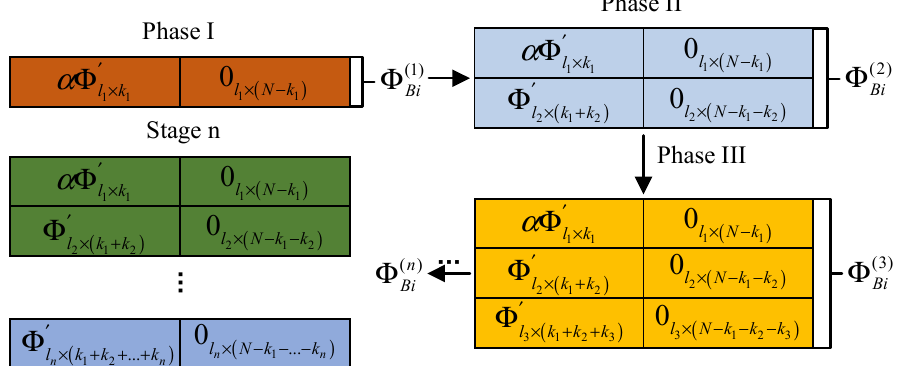
Figure 7. Schematic diagram of the image encoding end generating the observation matrix in stages.